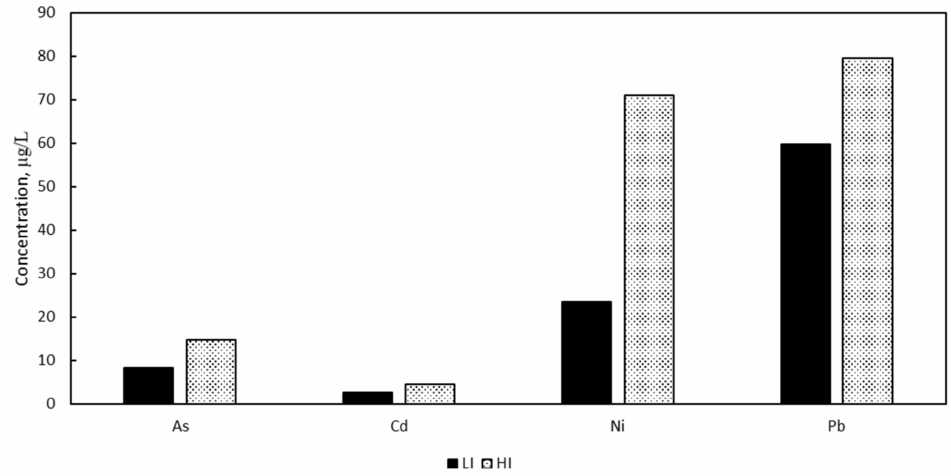
Figure 2. Heavy metals average concentrations measured in the patient blood of the LI and HI area, considering age, BMI, and attitude to